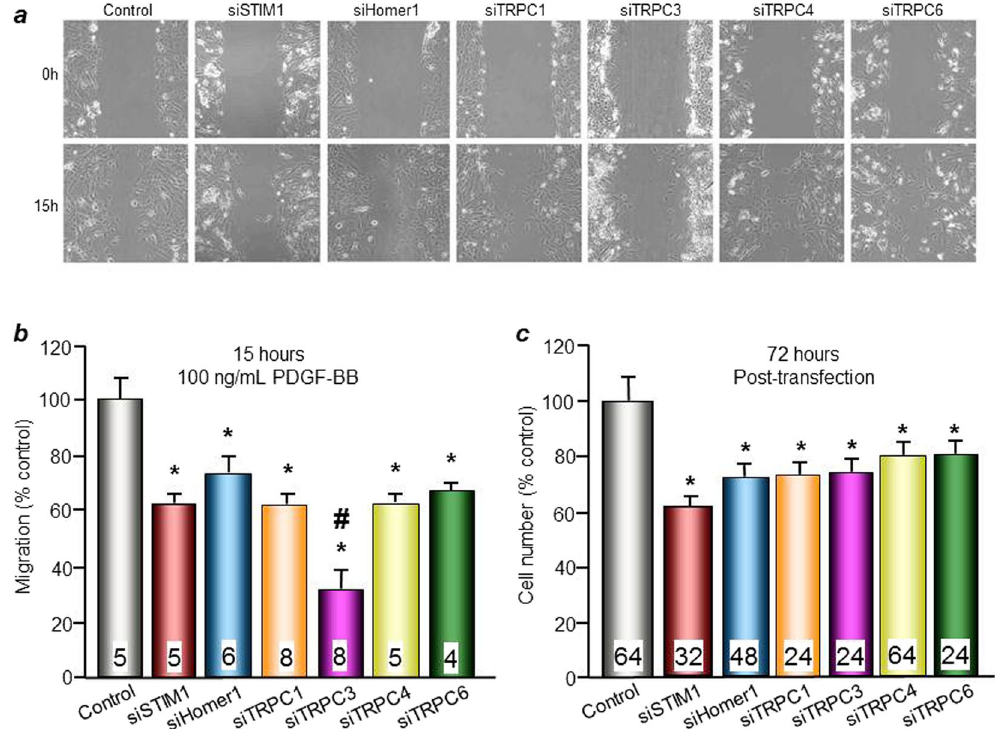
Figure 4. Effect of Homer1 knockdown on VSMC migration and proliferation. Cultured aortic VSMCs were transfected with various siRNAs, as indicated. ( a ) Representative brightfield views of scratch wound migration assay with 100 ng/mL PDGF-BB at 0 hr and 15 hrs and ( b ) Quantification of VSMC migration after 15 hrs as % control (% scrambled siRNA = 100%) compared to 0 hrs. SiHomer1, siSTIM1, siTRPC1, siTRPC3, siTRPC4, and siTRPC6 all reduce migration, with siTRPC3 being the lowest. * p < 0.05 or better compared to control # p < 0.01 compared to other 5 treatment groups and excludes control. ( c ) Proliferation of VSMCs in complete media containing 10% serum, as % control (% scrambled siRNA = 100%). All conditions, except for control, decrease cell number. * p < 0.01 compared to